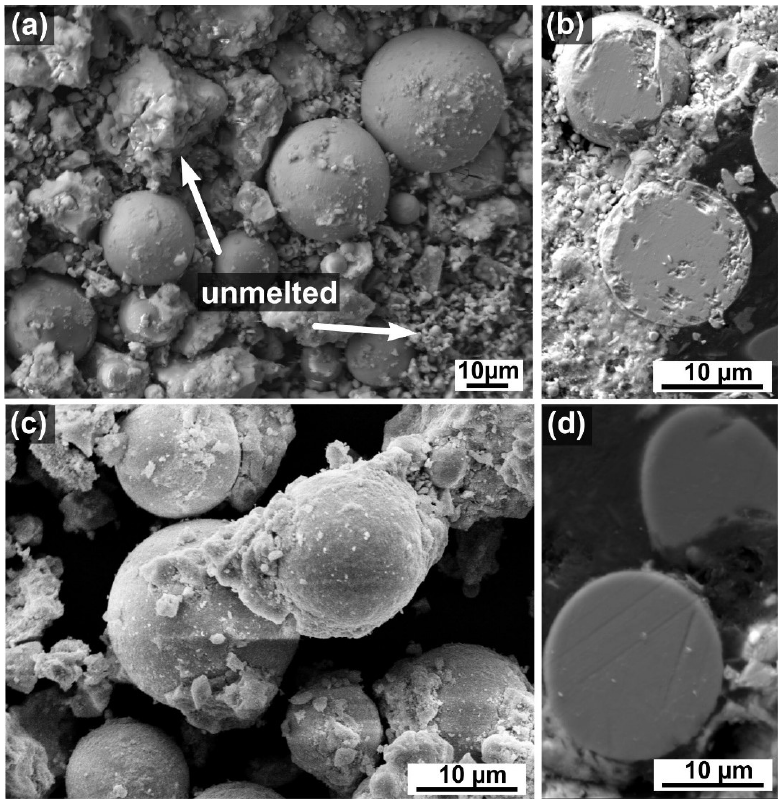
Figure 9. SEM images of spheroidized LC particles: ( a ) LC-SS surface view, ( b ) LC-SS cross-section, ( c ) LC-SG surface view, ( d ) LC-SG cross-section. ( c ) LC-SG surface view, ( d ) LC-SG